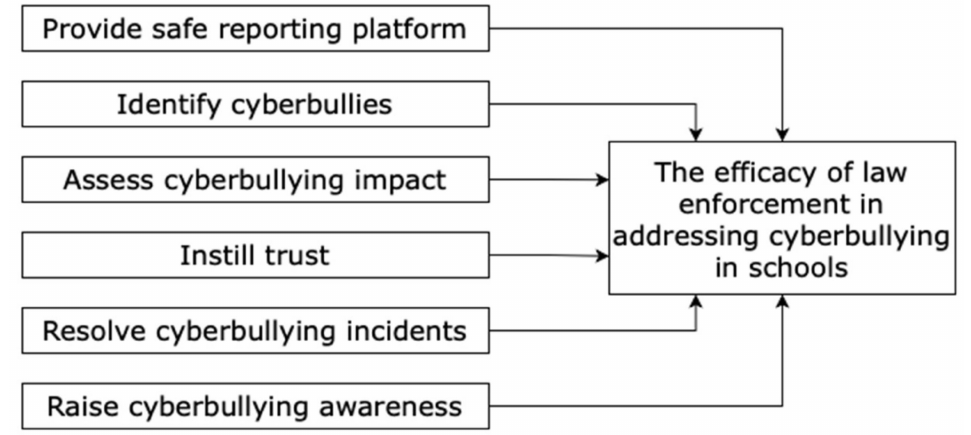
Figure 1. Conceptual framework for effective cyberbullying